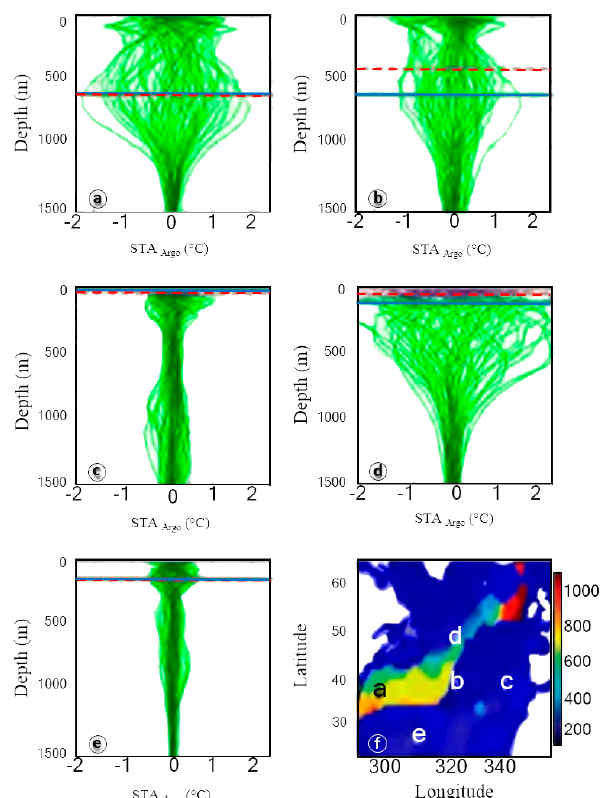
Figure 4. Argo subsurface temperature anomaly (STA) profiles from January 2005 to December 2010. ( a – e ) present STA profiles in areas labeled a, b, c, d, and e of subfigure ( f ). The geographic locations are: ( a ): western part of the North Atlantic subtropical gyre; ( b ): central part of the mid latitude North Atlantic; ( c ): eastern part of the mid latitude North Atlantic; ( d ): the sub polar gyre of the North Atlantic and ( e ): western part of the mid latitude North Atlantic [41]. ©American Meteorological Society. Used with permission.